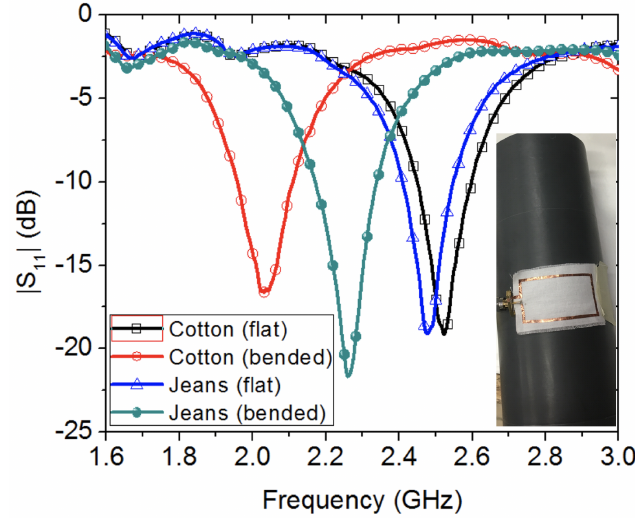
Figure 10. Experimental study of the effect of bending two wearable loop antenna prototypes, oriented perpendicular to the longitudinal axis of a cylindrical PVC fixture.